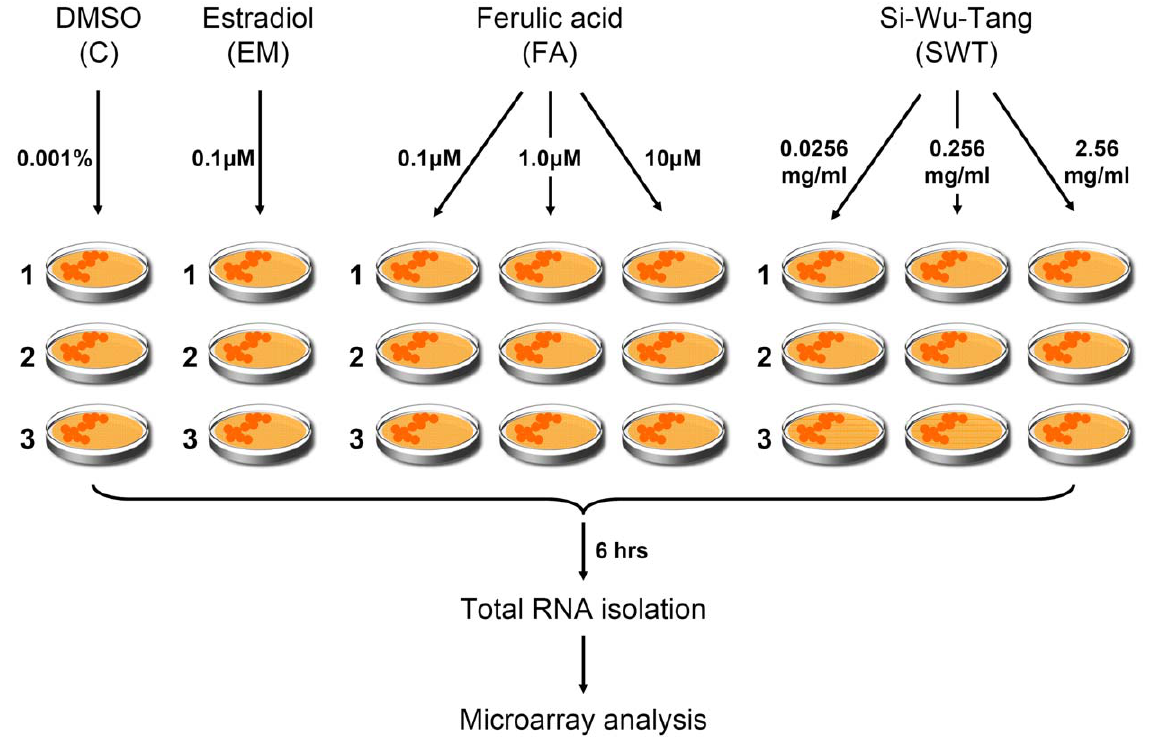
Figure 1. Experimental design of microarray gene expression profiling. The 24 samples were obtained from MCF-7 cells which were divided into eight treatment groups. 0.001% DMSO was used as the vehicle control (C). The cells were treated with 0.1 m M estradiol, FA at three concentrations (0.1, 1.0, and 10 m M) and SWT at three concentrations (0.0256, 0.256, and 2.56 mg/ml). For each treatment group, 3 biological replicates were